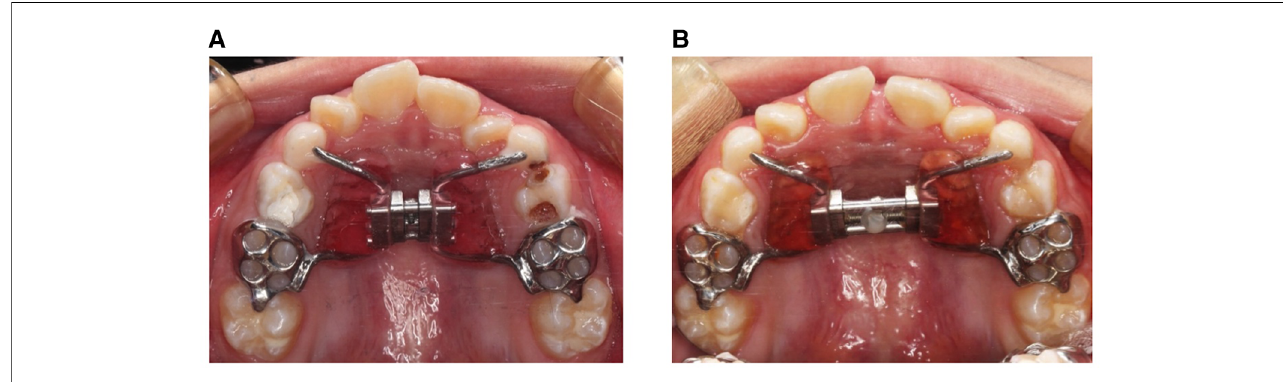
FIGURE 1 Haas expander appliance and facial pro fi le. ( A ) Occlusal view of the Haas expander before RME treatment. ( B ) Occlusal view of the expander after RME